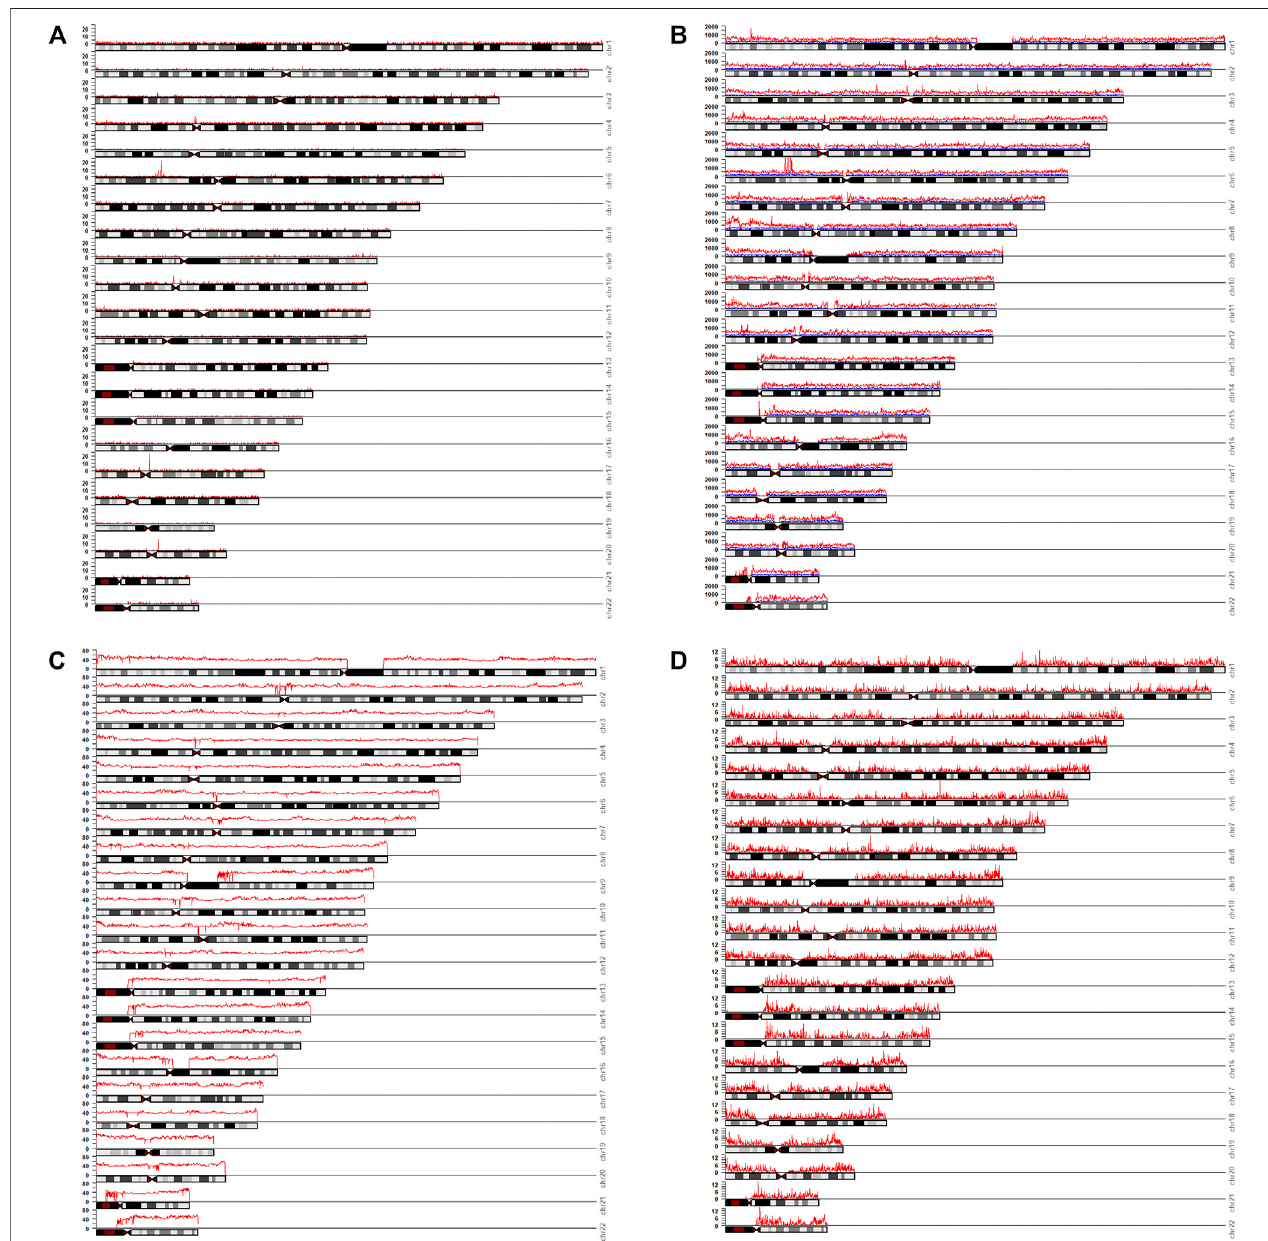
FIGURE3| DistributionofMM-InDelmarkersand related factorsacrossthegenome.DistributionsofMM-InDelswithrandomsequences (in red ) (A) ,SNPs(in red ) andInDels(in blue ) (B) ,GCcontents(in red ) (C) ,andrecombinationrates(in red ) (D) acrossthewholegenome.ThenumbersofMM-InDels,allSNPsandInDels,andthe average values of GC contents and recombination rates are shown for 100-kb